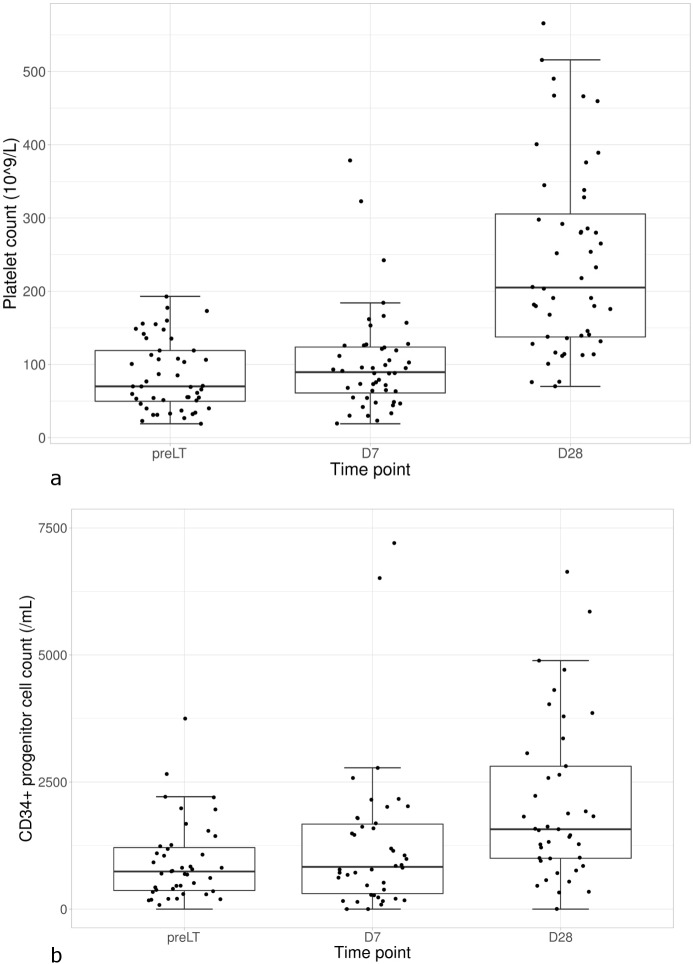
(A) Boxplots for platelet count and (B) CD34+ hematopoietic progenitor stem cells at different time points. Horizontal lines show median values and the 25–75 percentiles. Pre LT: pre liver transplantation.